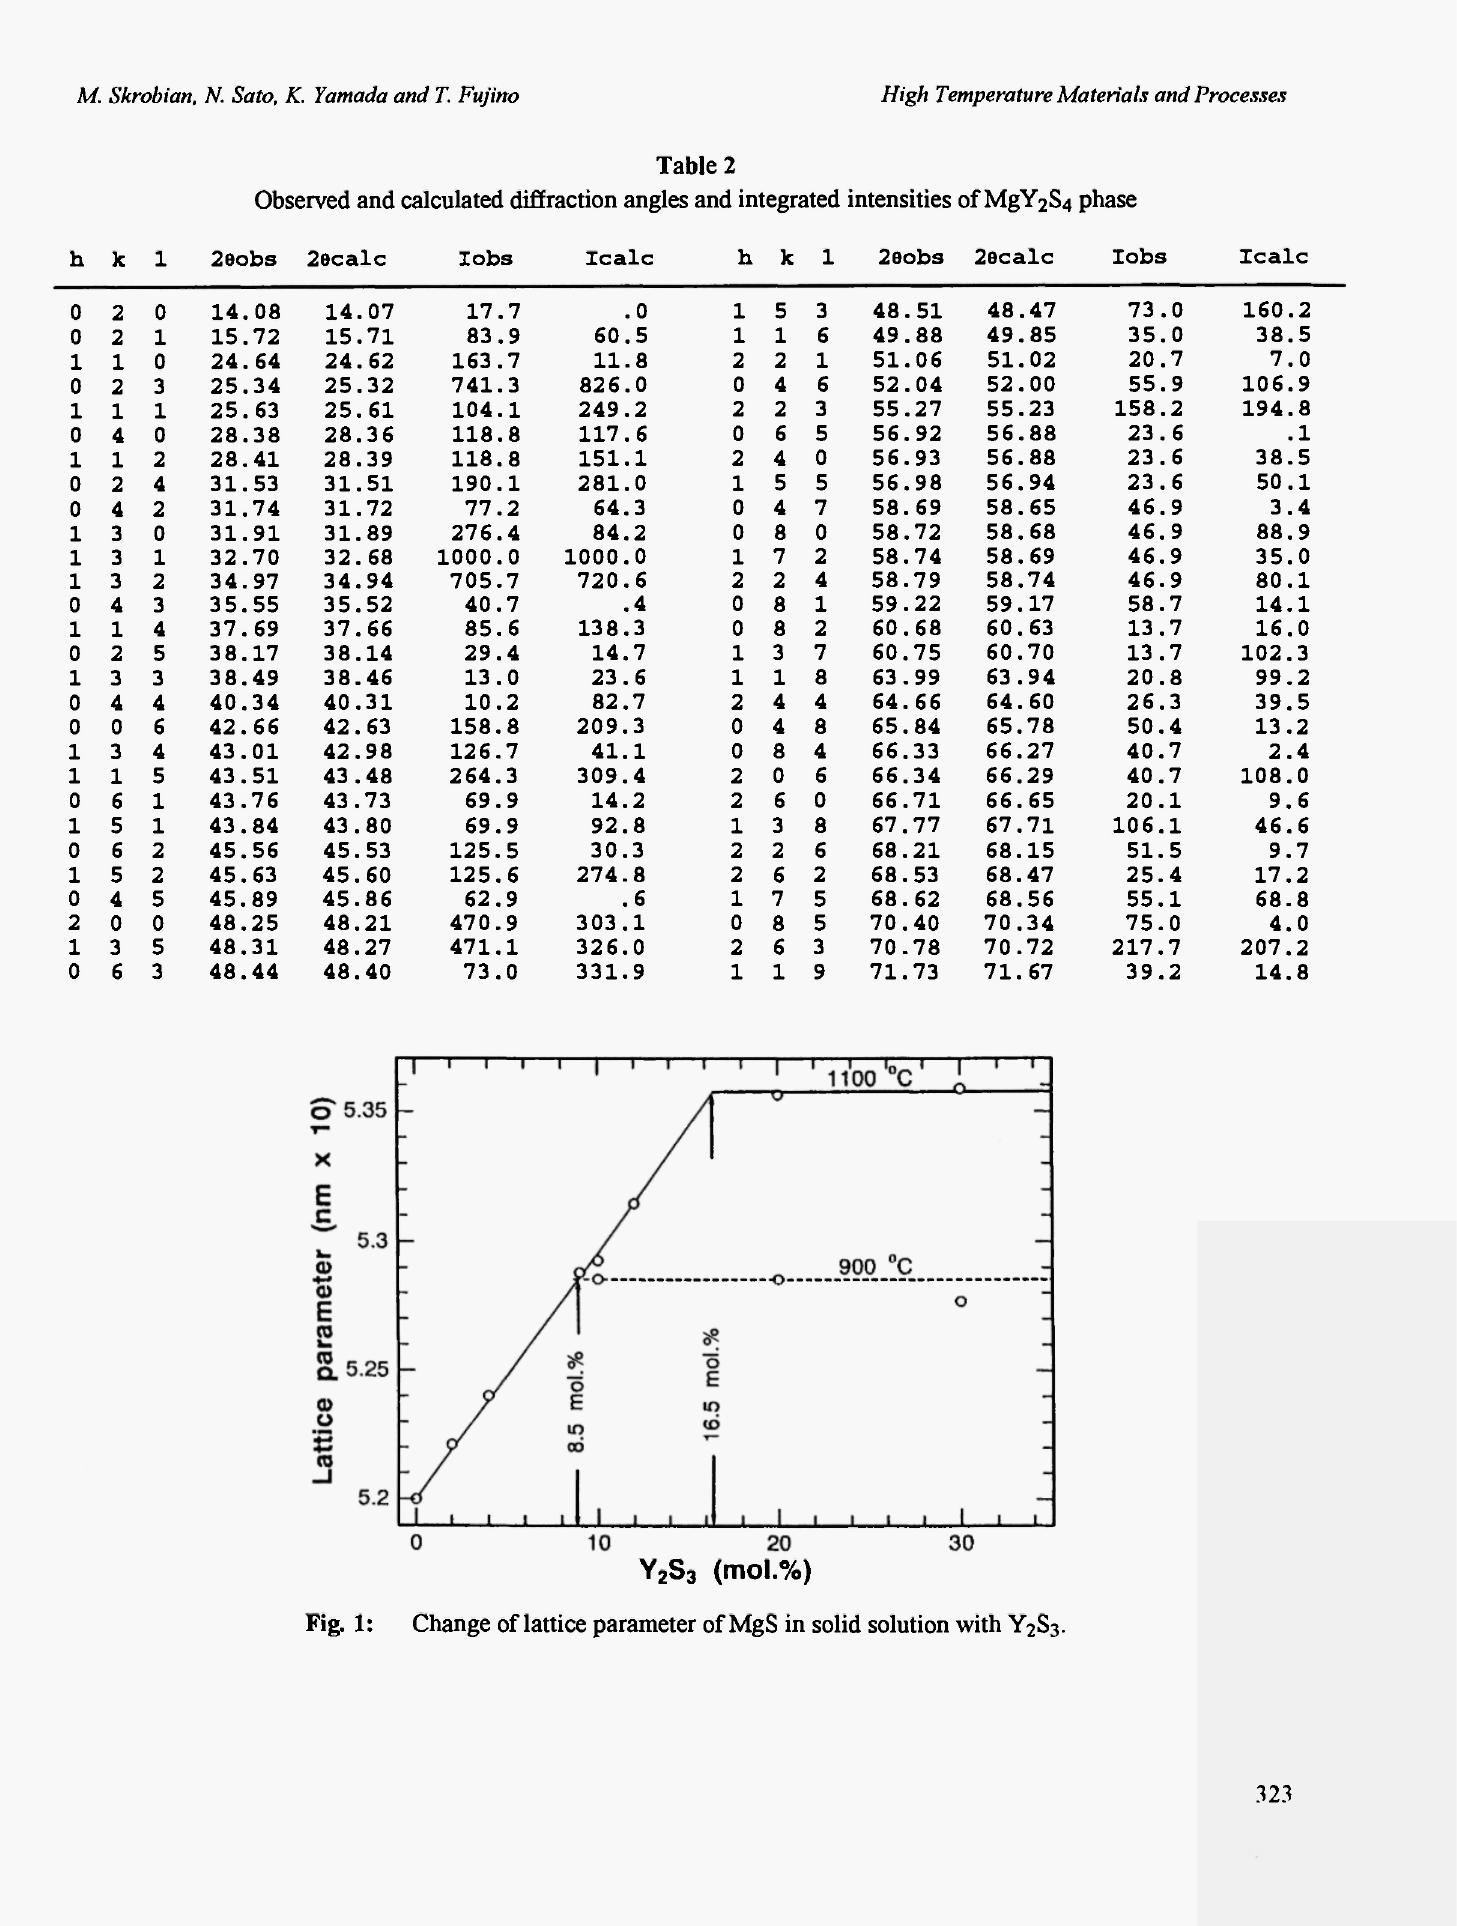
Fig. 1: Change of lattice parameter of MgS in solid solution with